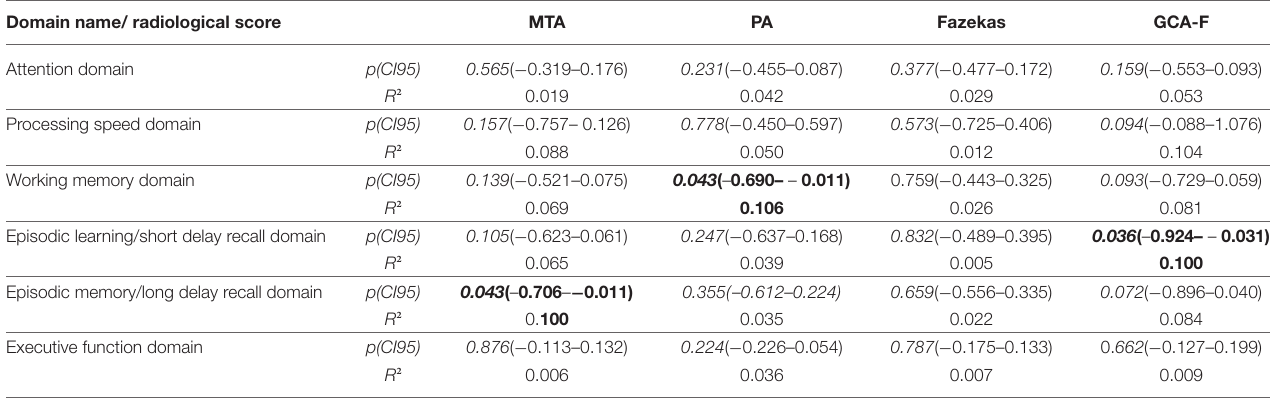
TABLE 8 | Correlations between MRI scores and cognitive domains Z-scores in MCI patients. Domain name/ radiological